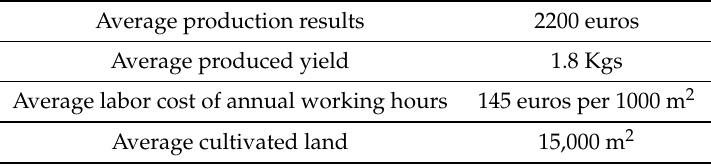
Table 6. Greek saffron cultivation economic estimation in one